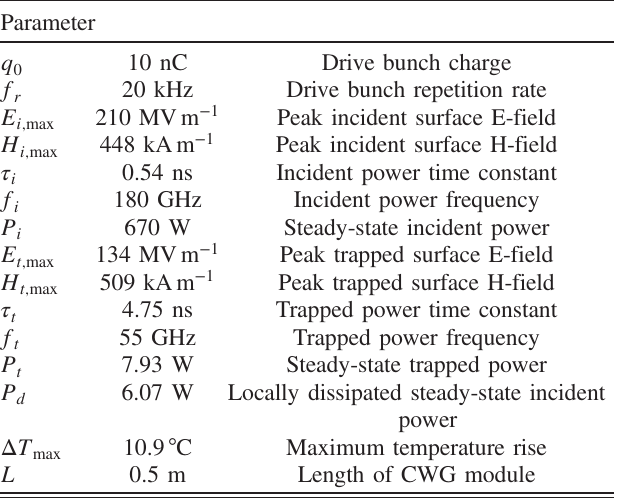
TABLE II. A-STAR transition section operating